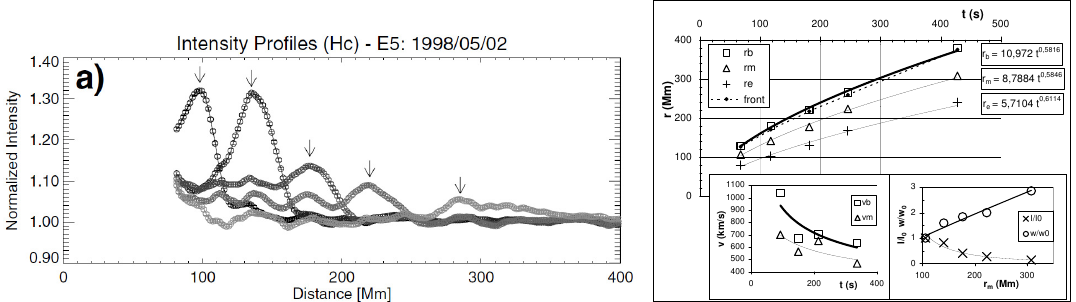
Figure 26: Perturbation profile evolution in the Moreton wave of 1998 May 2 (cf. Figure 9). Left : H α center line intensity profiles normalized by the pre-event profile. The propagation of the Moreton wave is clearly seen, as is the decrease of its amplitude and the increase of the pulse width. Right : the main panel shows the distance-time diagram of the wave’s leading edge, intensity maximum, and trailing edge, respectively. The evolution of the speeds (depicted at the lower left) clearly shows deceleration. The panel on the lower right shows the decrease of the amplitude ( crosses ) and the increase of the width ( circles ) of the wavefronts. Images reproduced with permission from [left] Warmuth et al. (2004b), copyright by ESO, and [right] Warmuth et al. (2001), copyright by